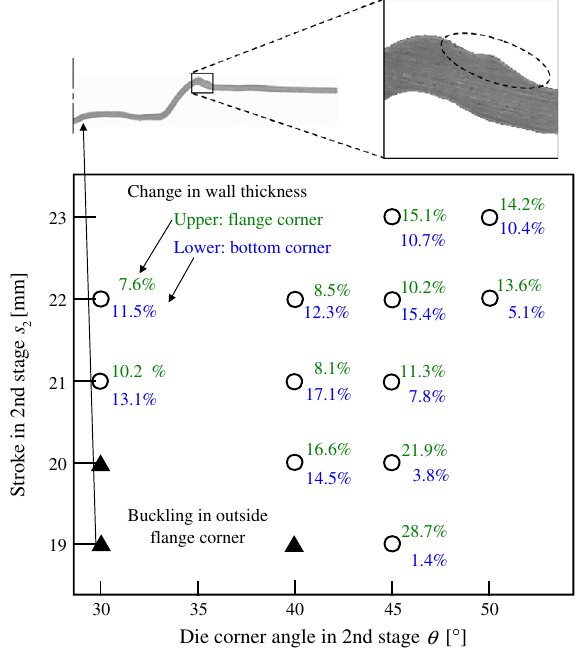
Figure 12. Forming range and changes in wall thickness at flange and bottom corners for contact of inclined portion with counter punch in 3rd stage.